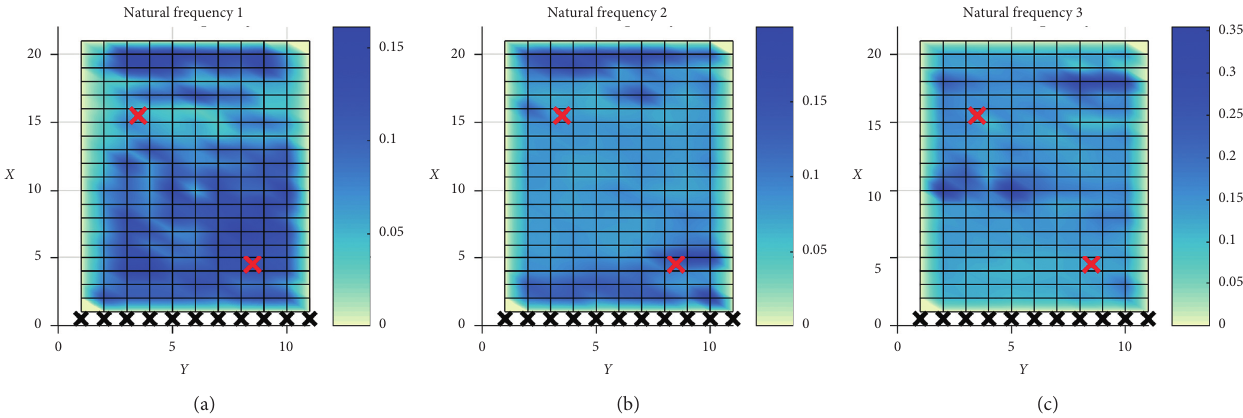
Figure 13: Outcome of the LMFs tuned to the first three natural frequencies of the plate for maximum damage: (a) natural frequency 1, (b) natural frequency 2, and (c) natural frequency 3.